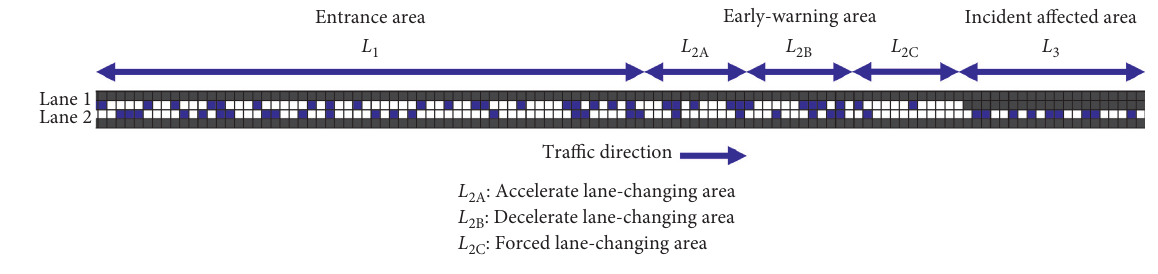
Figure 2: Schematic of the automated-driving